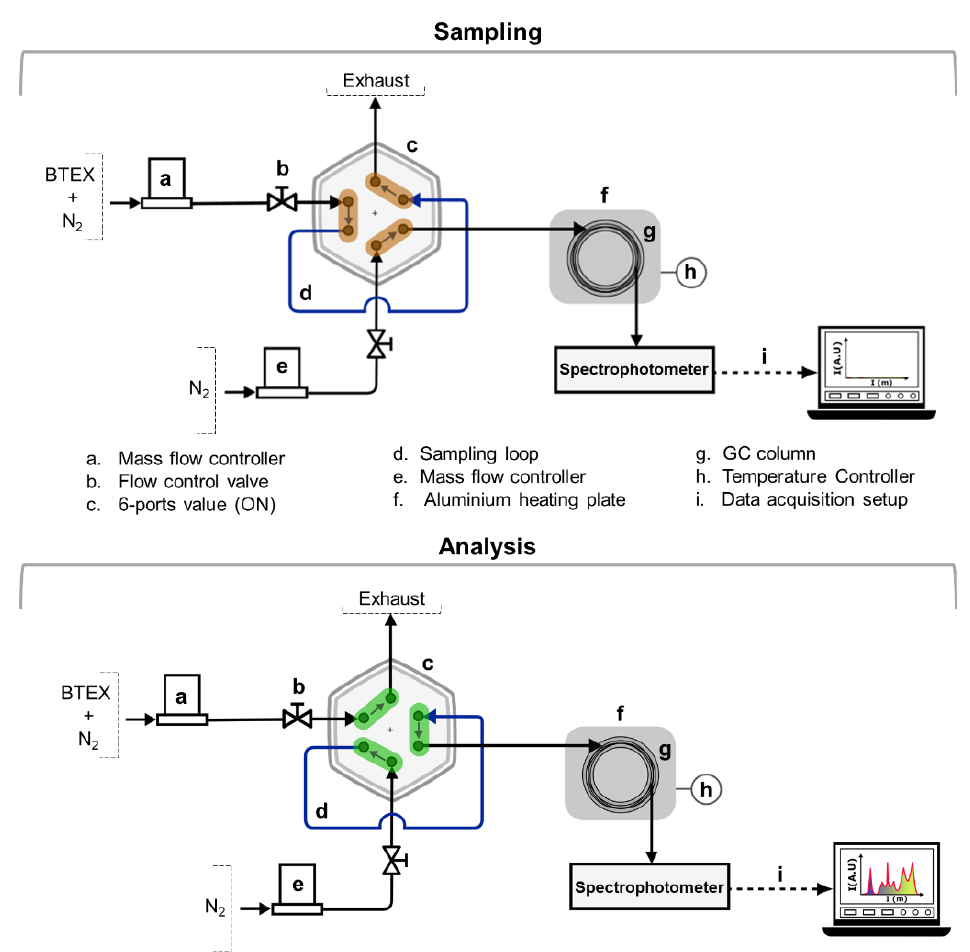
Figure 3. Schematic of the μGC setup with the absorbance detector. Sampling mode, i.e., 6-ports value—OFF (top) and the analysis mode, i.e., 6-ports value—ON (bottom) for GC.